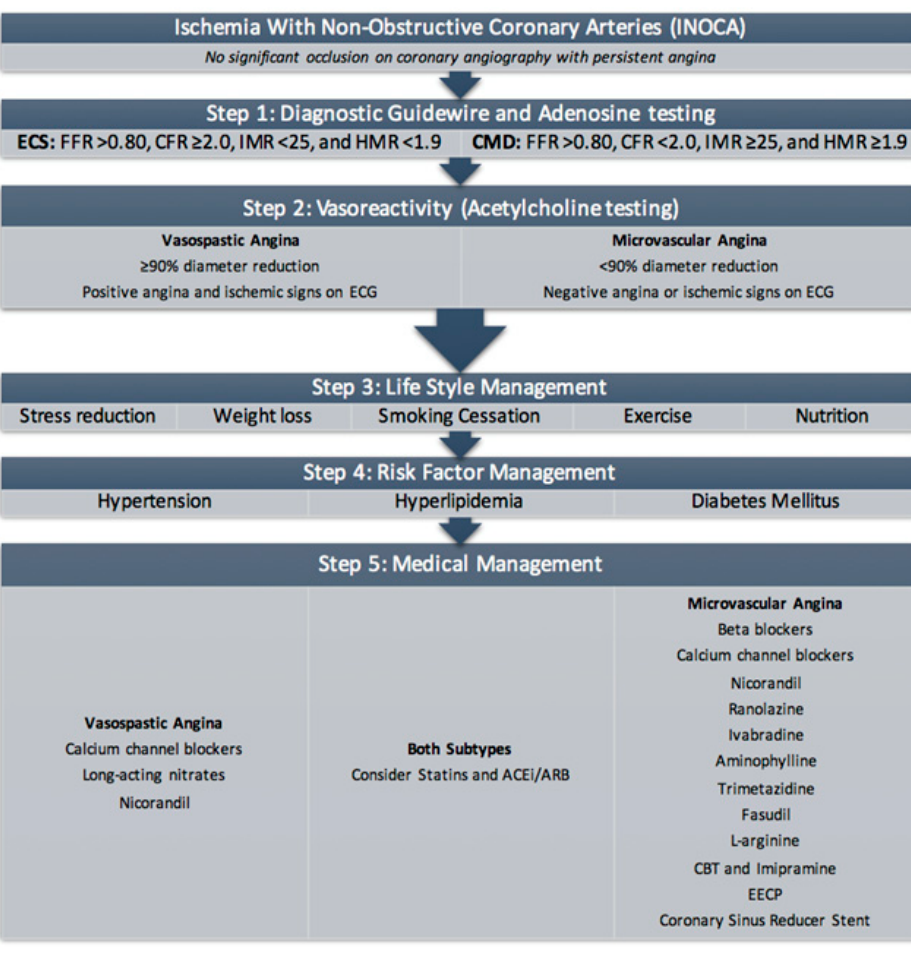
Figure 2. Diagnosis and treatment of coronary microvascular dysfunction.